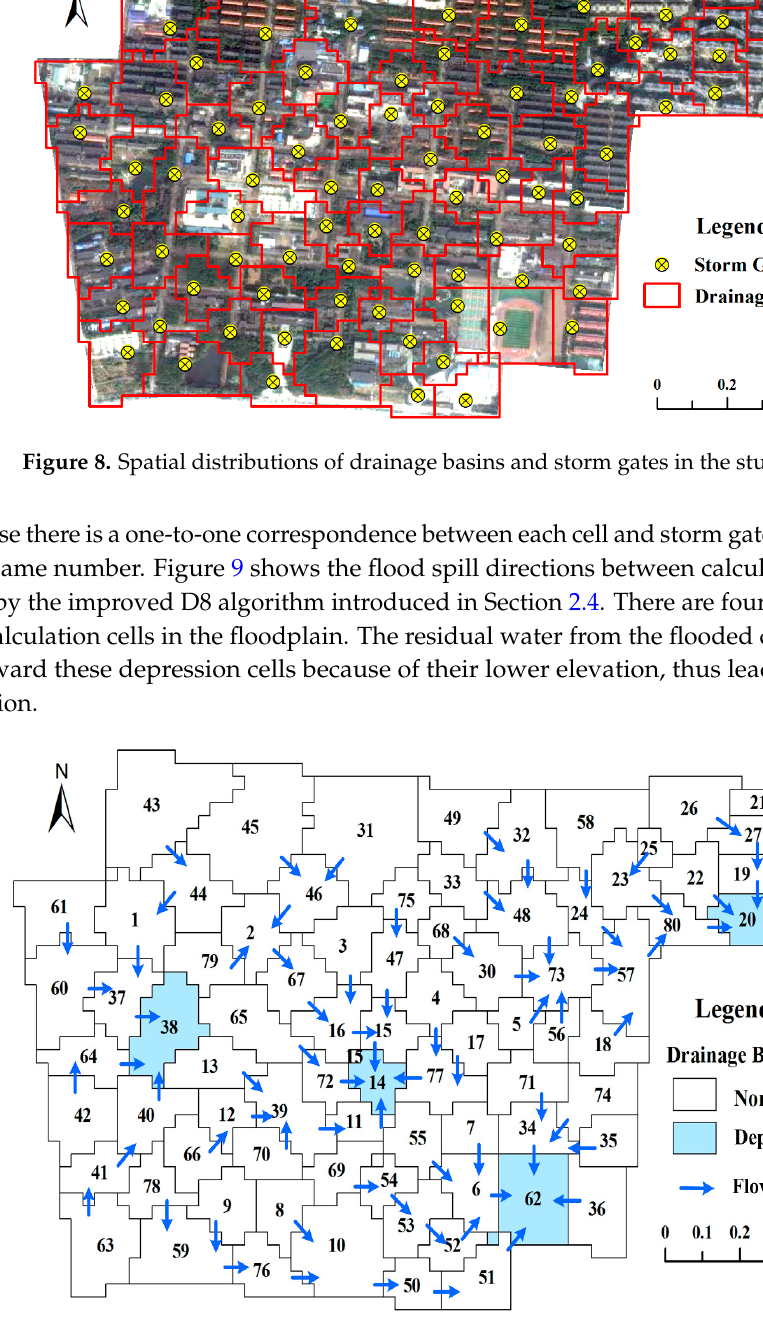
Figure 9. Flow directions between drainage basins in the study area.